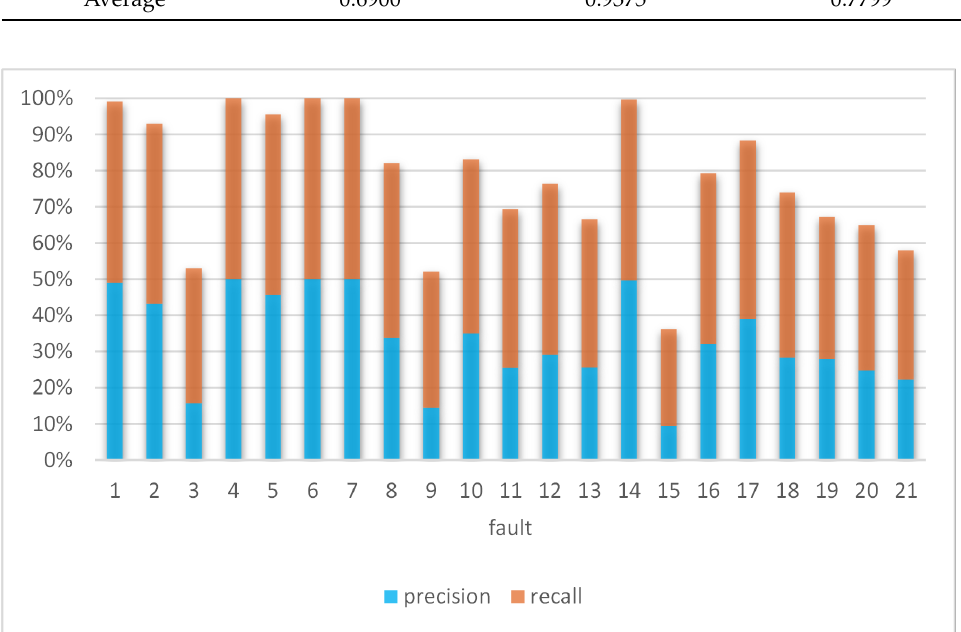
Figure 6. Stacked graph of precision and